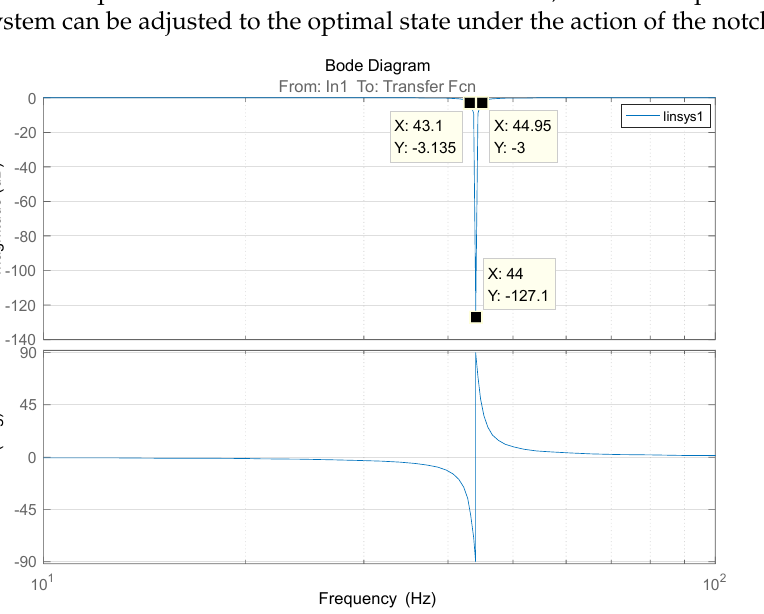
Figure 4. Spectrum characteristics of second-order digital filter.